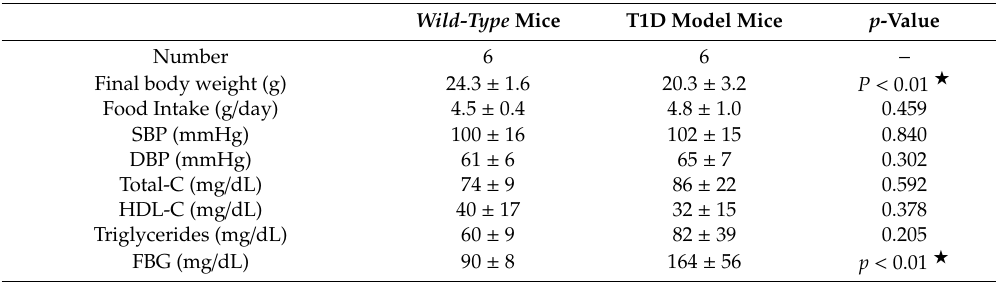
Table 1. Laboratory characteristics of wild-type mice and streptozotocin-induced type 1 diabetes mice at 13 weeks